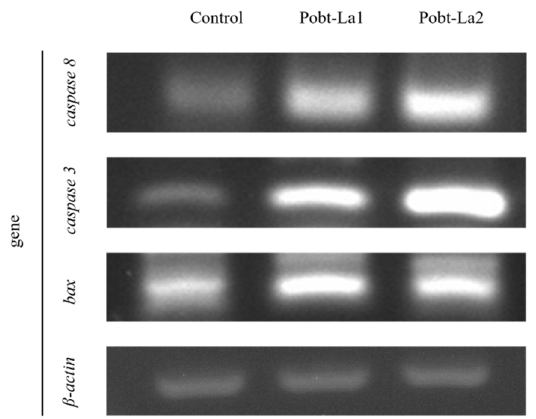
Figure 3. RT-PCR results of apoptosis associated gene expression.